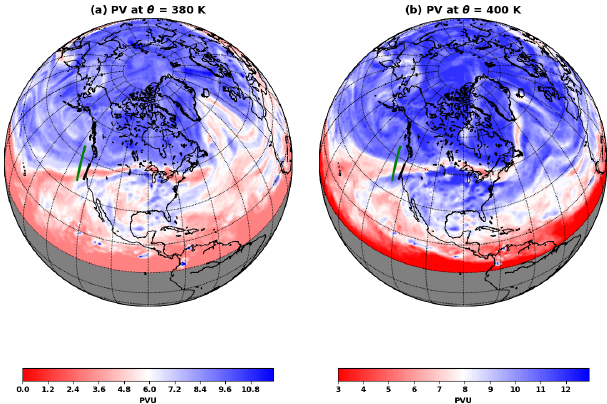
Figure 3. Potential vorticity on the 380 (a) and 400K (b) isentropic surfaces for the 18:00UTC, 21 July 2017, time step. The measure- ment tracks of SHOW and MLS are shown in black and green re-